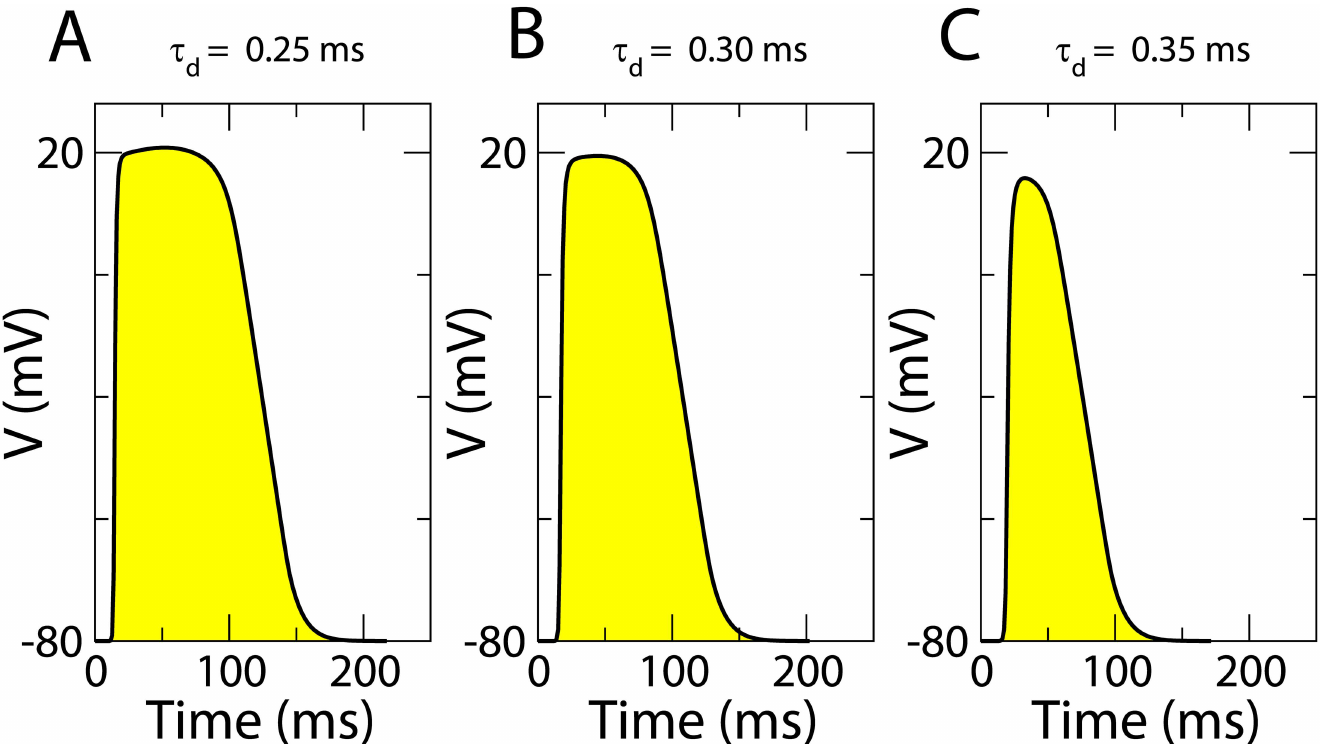
Fig 1. Transmembrane voltage evolution for different remodeling levels. Shape of the action potential durationfor different values of τ d employedin the three-dimensional simulations: τ d = 0.25 ms (A), τ d = 0.30 ms (B), and τ d = 0.35 ms (C). Parameters used are: t þ ms , t þ = 667 ms , t (cid:0) = 11 ms , τ o = 8.3 ms , τ r = 50 ms , τ si = 45 ms , k = 10, V si w w values are kept constant for the rest of